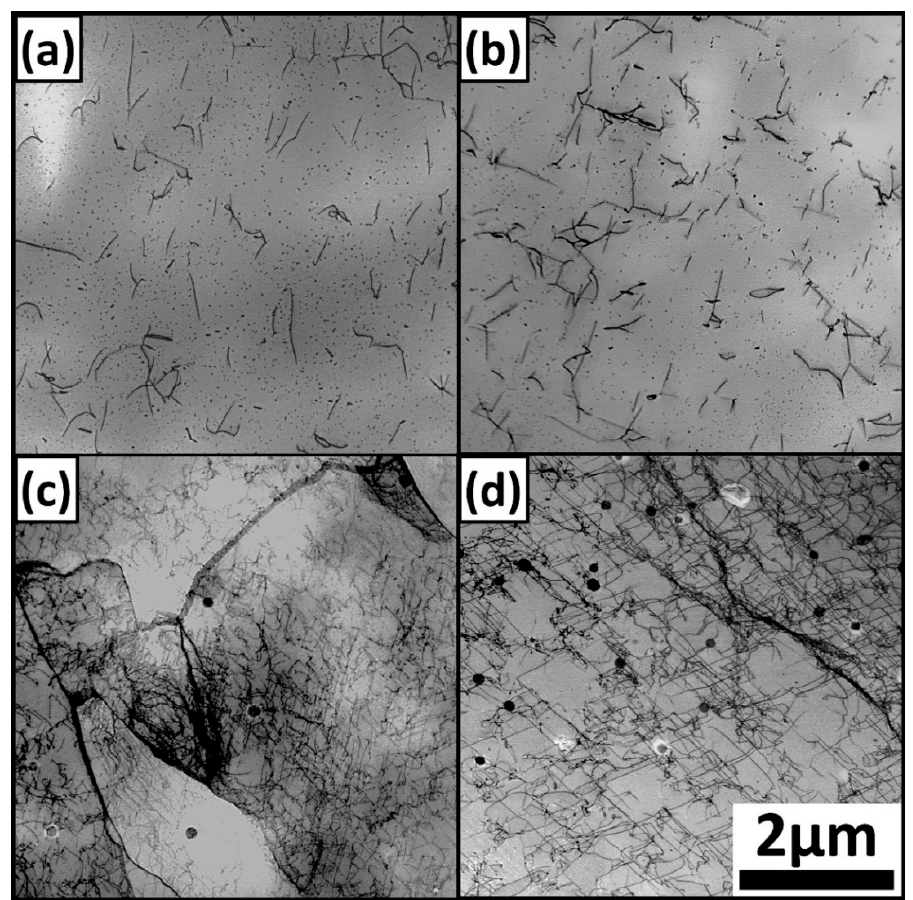
Figure 8. TEM micrographs: ( a , b ) allotriomorphic ferrite in Steel A and Steel B, respectively, and ( c , d ) massive ferrite in Steel A and Steel B, respectively.